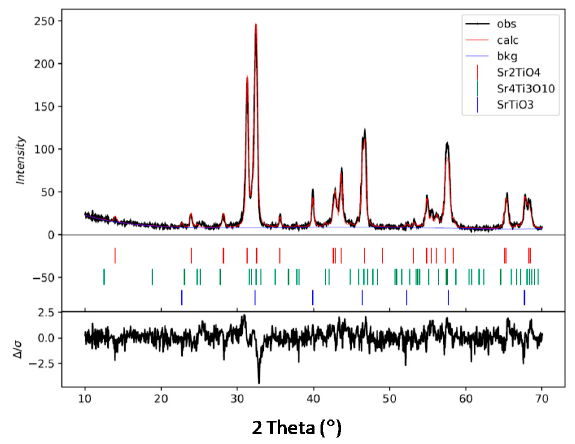
Figure 9. The experimental XRD pattern of MA-3 annealed at 1100 ◦ C (black) and the theoretical one calculated using a model of crystal structure of strontium titanates (red).